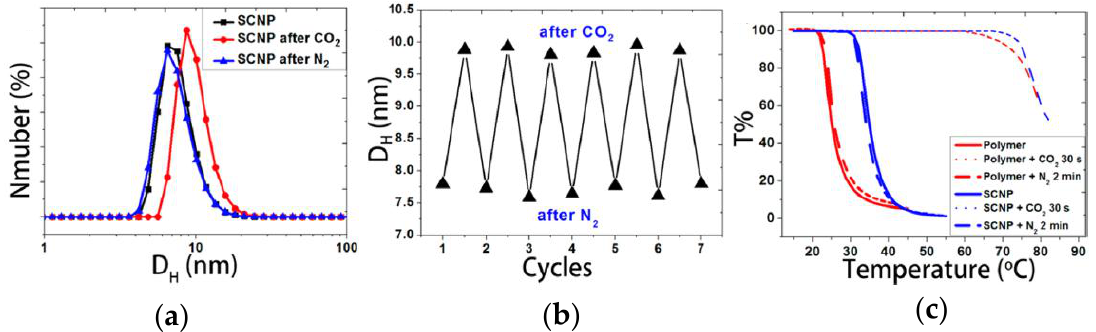
Figure 14. Changes in the hydrodynamic size distribution of N , N -dimethylaminoethyl methacrylate (DMAEMA)-containing SCNPs in water upon bubbling CO 2 and N 2 for 10 min ( a ); demonstration that the CO 2 capture and release by these SCNPs as nanocontainers is a reversible process ( b ); and influence of CO 2 capture and release on the thermoresponsive behavior of the precursor polymer and the corresponding SCNPs ( c ) (reprinted from [61] with permission, Copyright American Chemical Society,